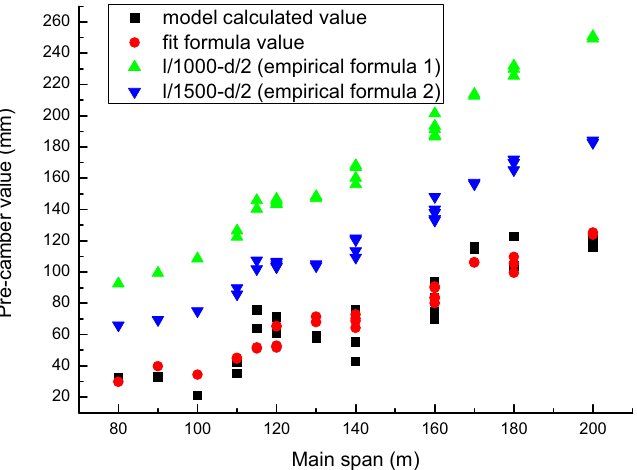
Figure 7. Comparison of model calculation value, fitting formula value and empirical formula value.